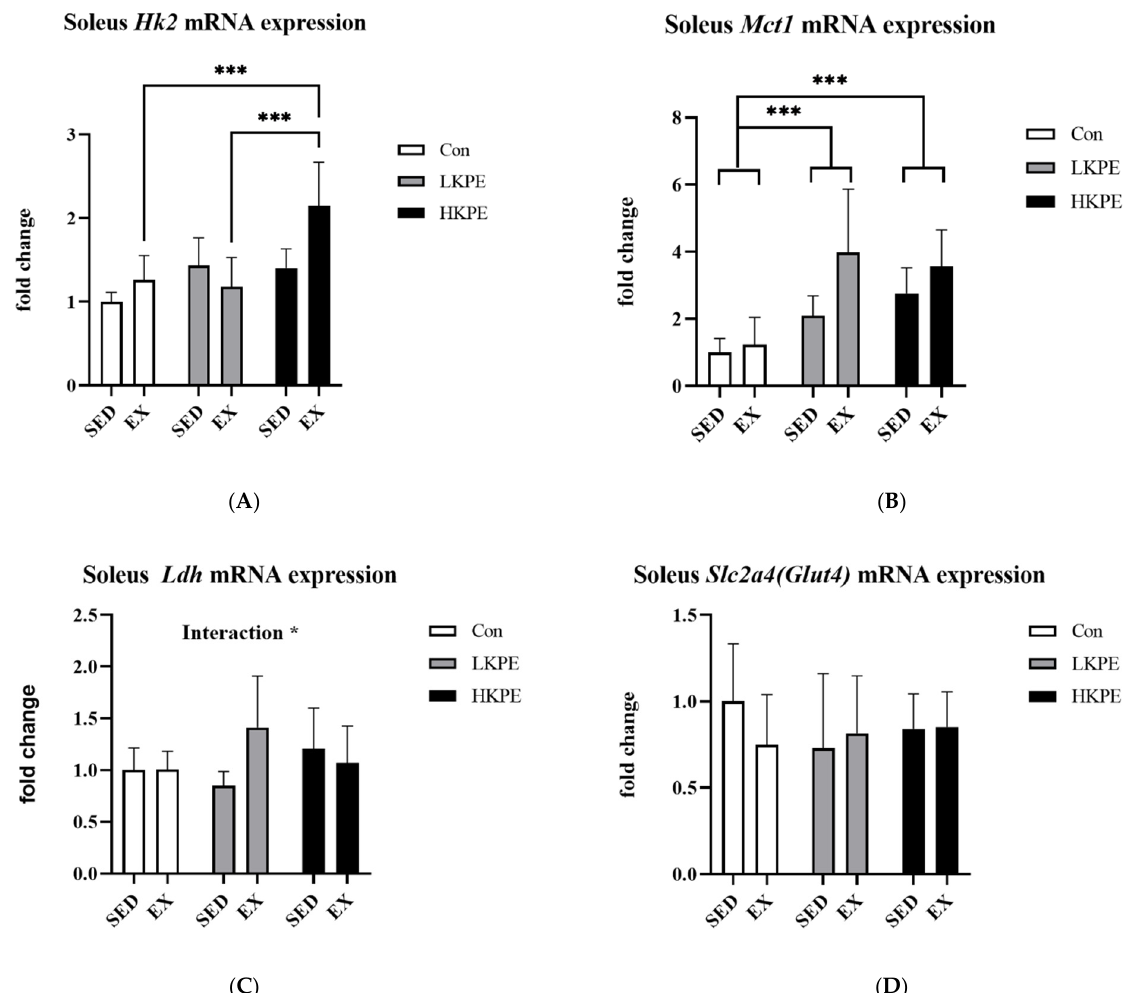
Figure 5. mRNA expression of ( A ) Hk2 , ( B ) m Mct1 , ( C ) Ldh, and ( D ) Slc2a4 (Glut4) in soleus muscle immediately after exhaustion. Hk2 , hexokinase 2; Slc2a4 (Glut4) , solute carrier family 2 (facilitated glucose transporter); Mct1 , monocarboxylate transporter 1; Ldh , lactate dehydrogenase; SED, sedentary; EX, exercise; Con, control; KPE, Kaempferia parviflora administration; * p < 0.05, *** p <